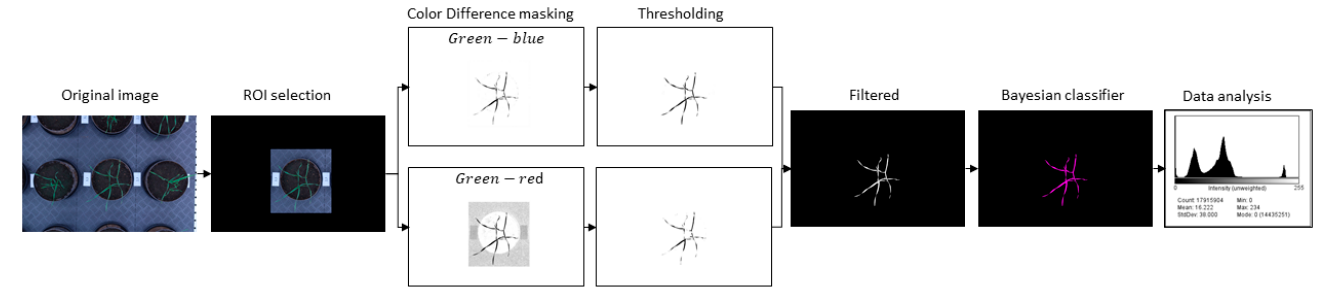
Figure 2. Work flow of image analysis pipeline performed for the extraction of the projected plant biomass from top-view digital images.